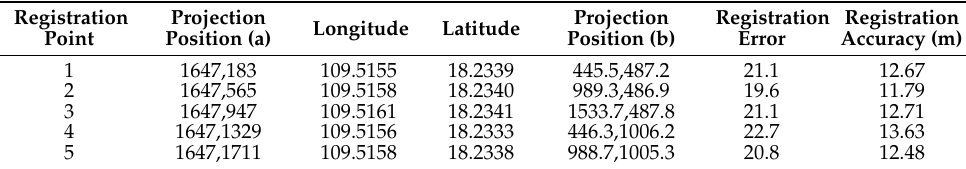
Figure 14. Schematic diagram of feature free image and registration point selection. Table 7. Calculation results of geographical position of registered pixel